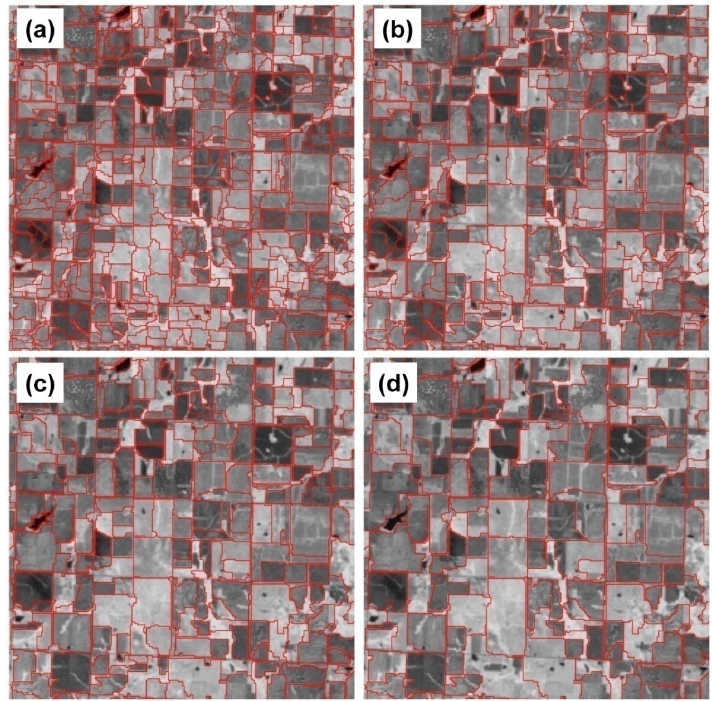
Figure 7. Demonstration of image segmentation at four scale levels: ( a ) scale parameter 10; ( b ) scale parameter 15; ( c ) scale parameter 20; and ( d ) scale parameter 30. parameter 15; ( c ) scale parameter 20; and ( d ) scale parameter